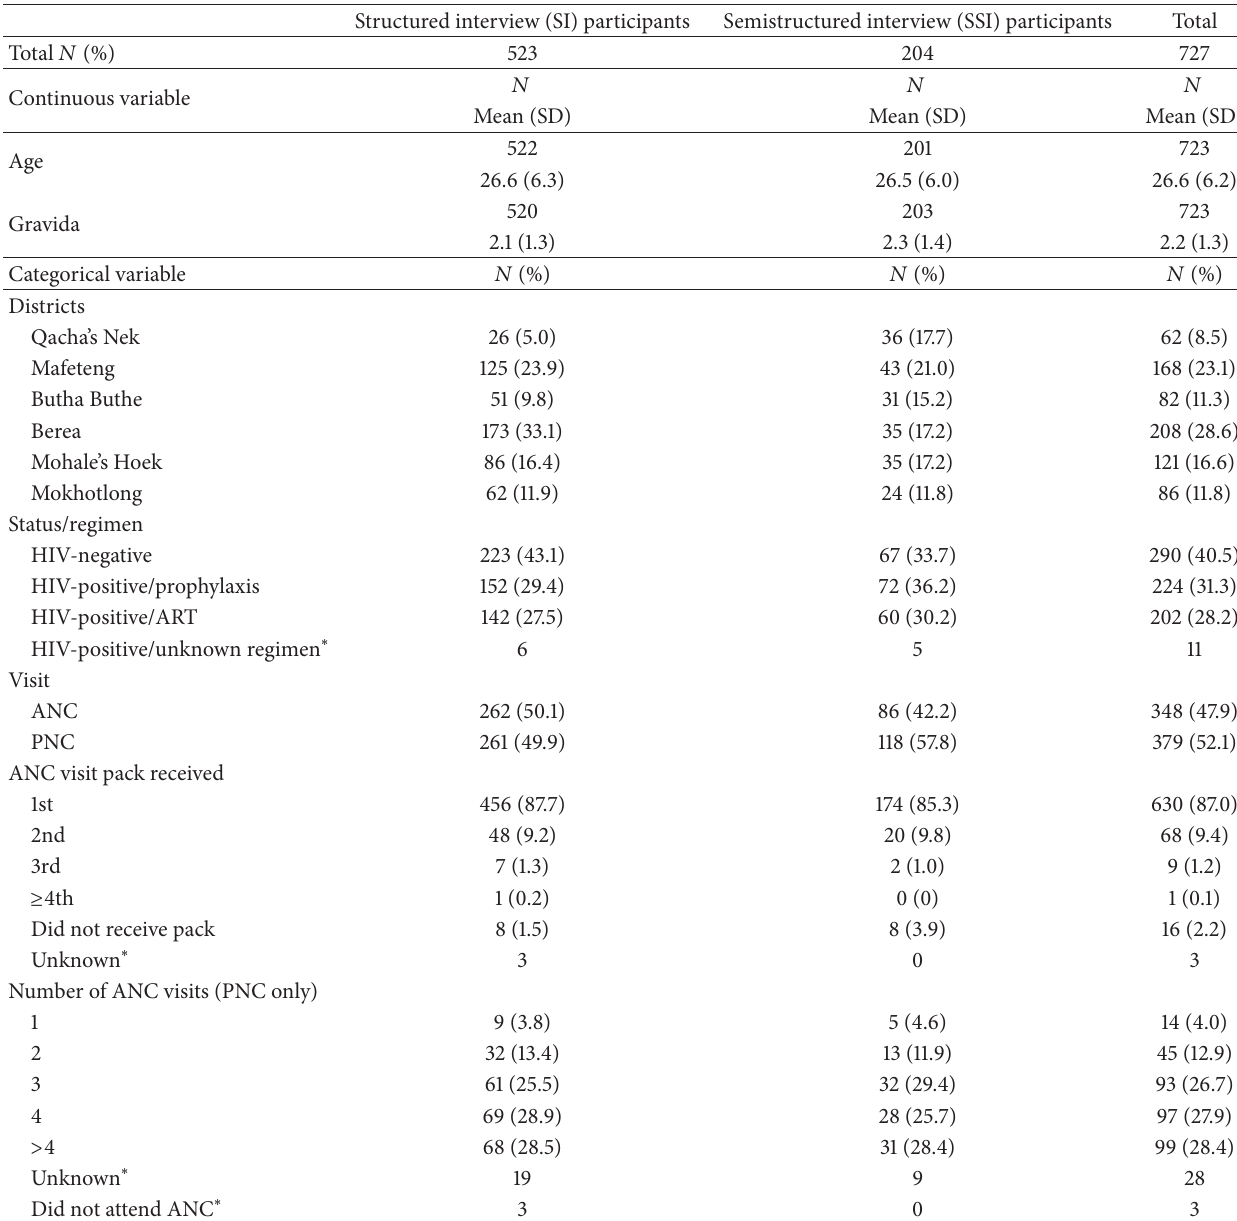
Table 1: Characteristics of study